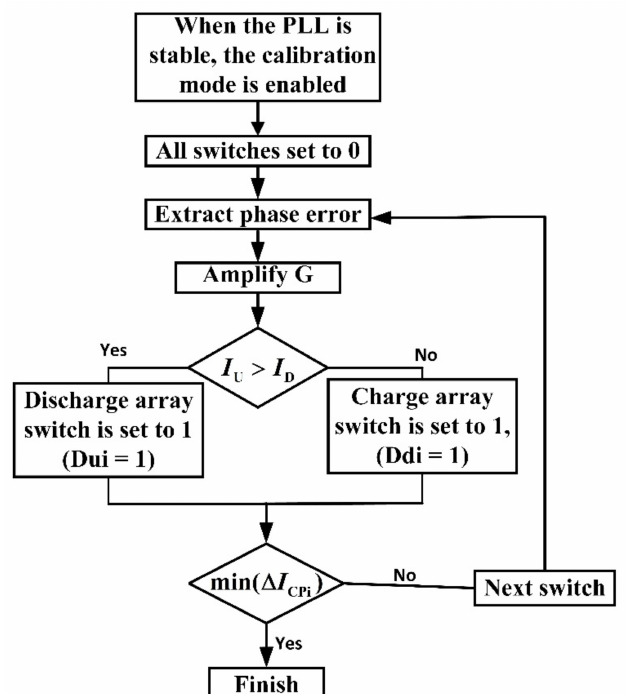
Figure 6. Flowchart for DAMC.